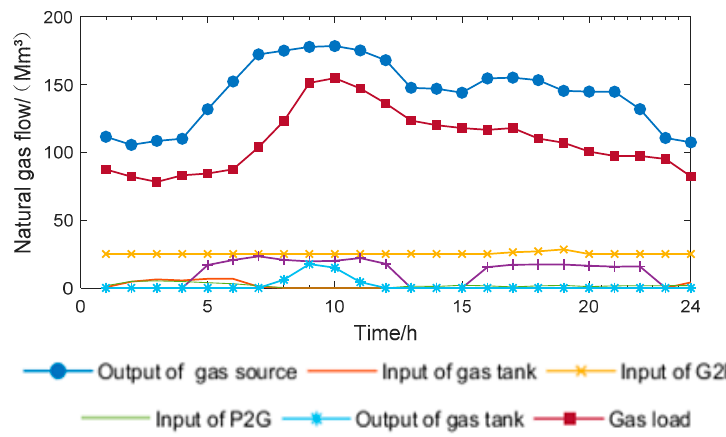
Figure 5. Gas network optimized operation data.